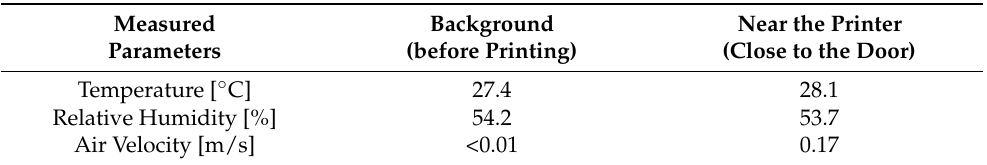
Table 2. Environmental characterization provided by the thermo-hygrometer: Air velocity, room temperature and relative humidity.